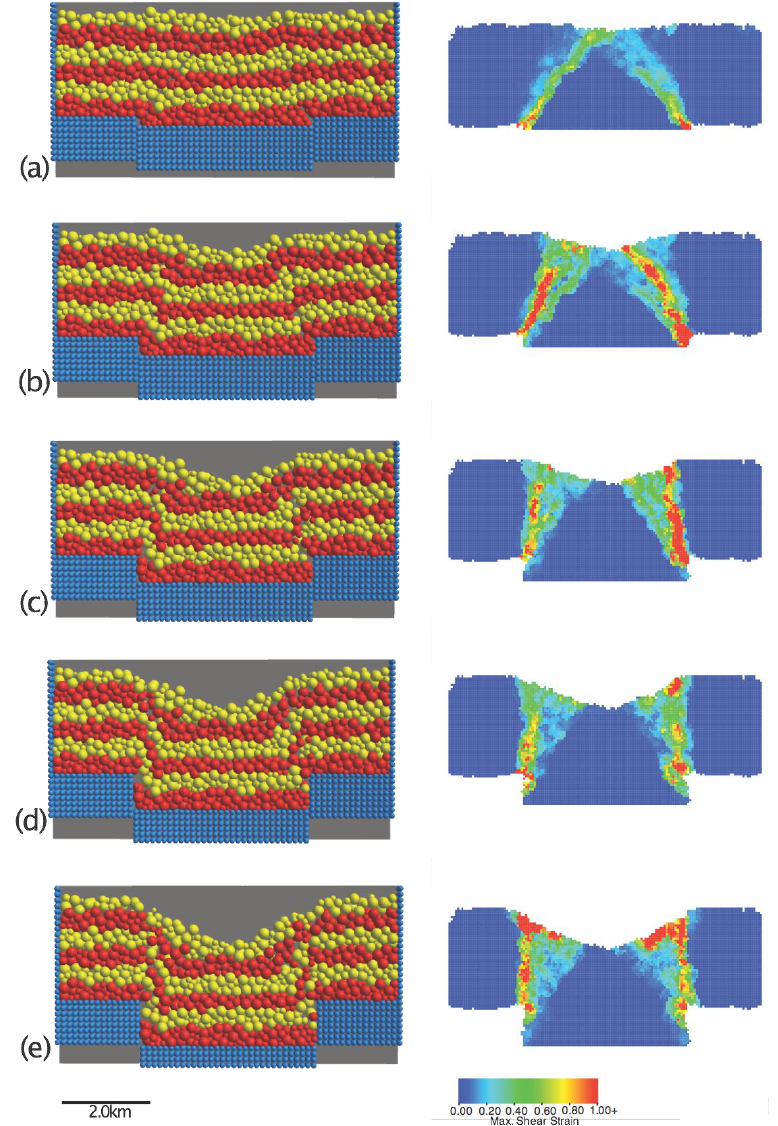
Figure 5. Evolution of vertical section A: caldera geometry (left) and incremental shear strain accrued during the preceding 200 m of basal subsidence (right) at ( a ) 200, ( b ) 400, ( c ) 600, ( d ) 800, and ( e ) 1000 m basal subsidence for an experiment with a flat, circular roof.